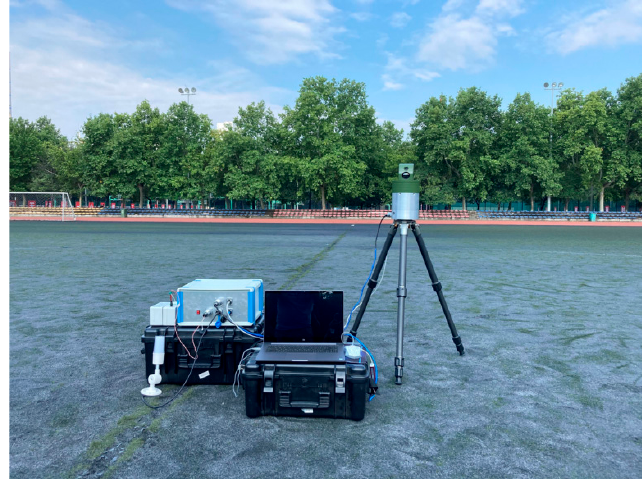
Figure 11. The novel system in the testing scenario.